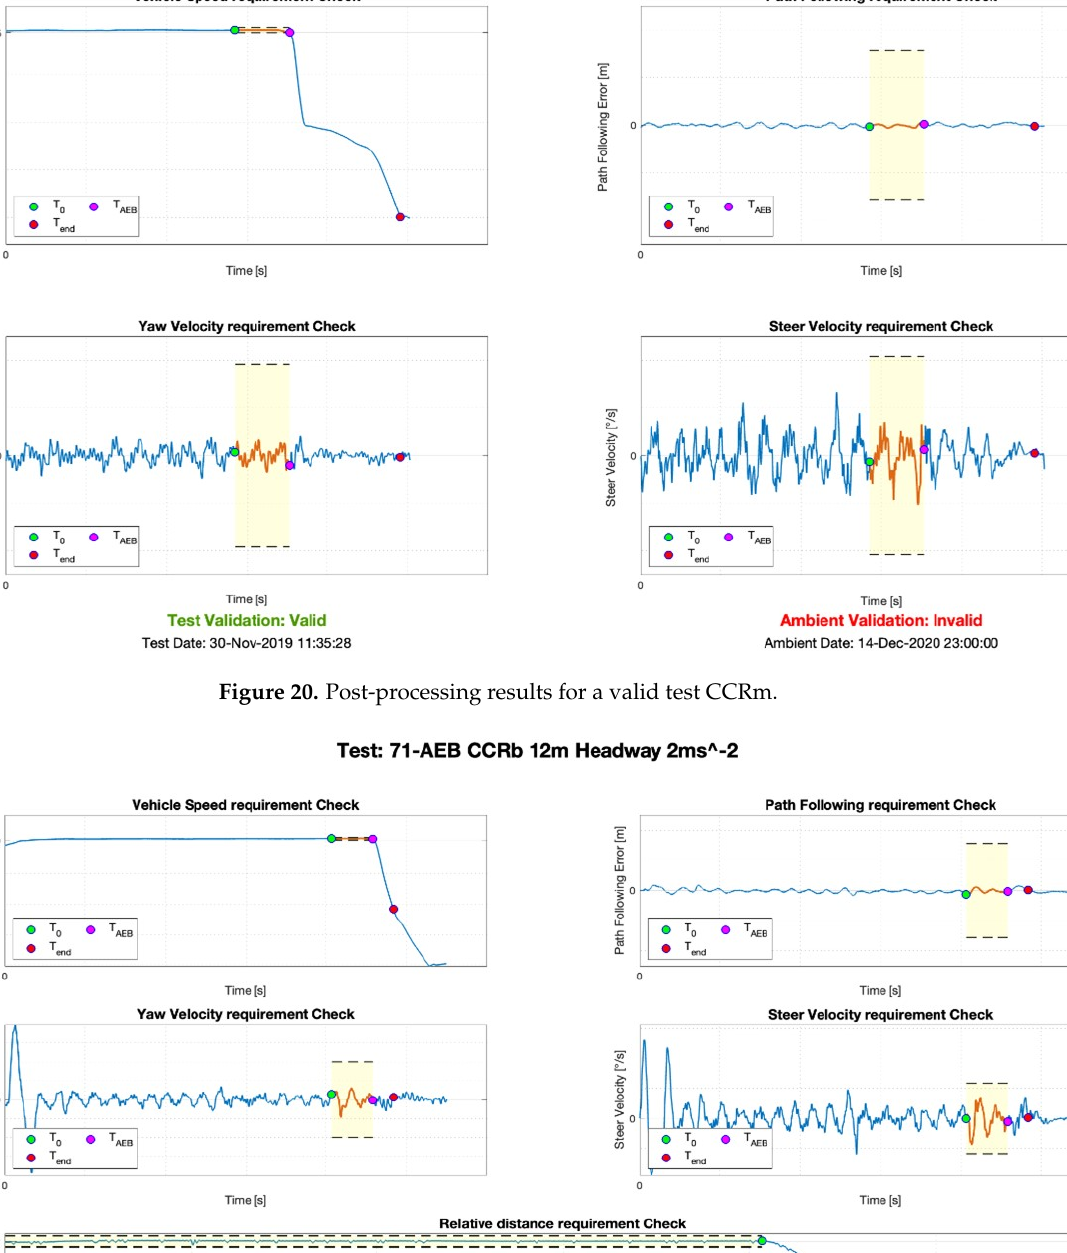
Figure 19. Post-processing results for a valid test CCRs.